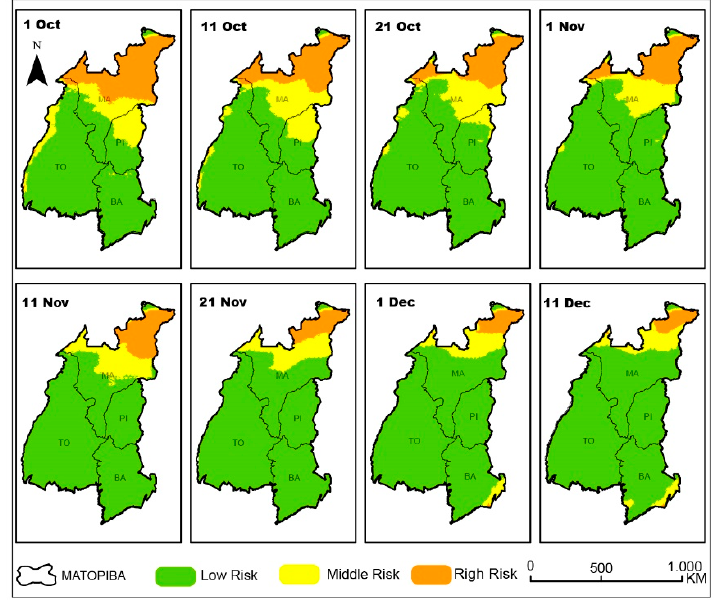
Figure 4. Agroclimatic risk of soybean culture in the MATOPIBA region for the climatology scenario.